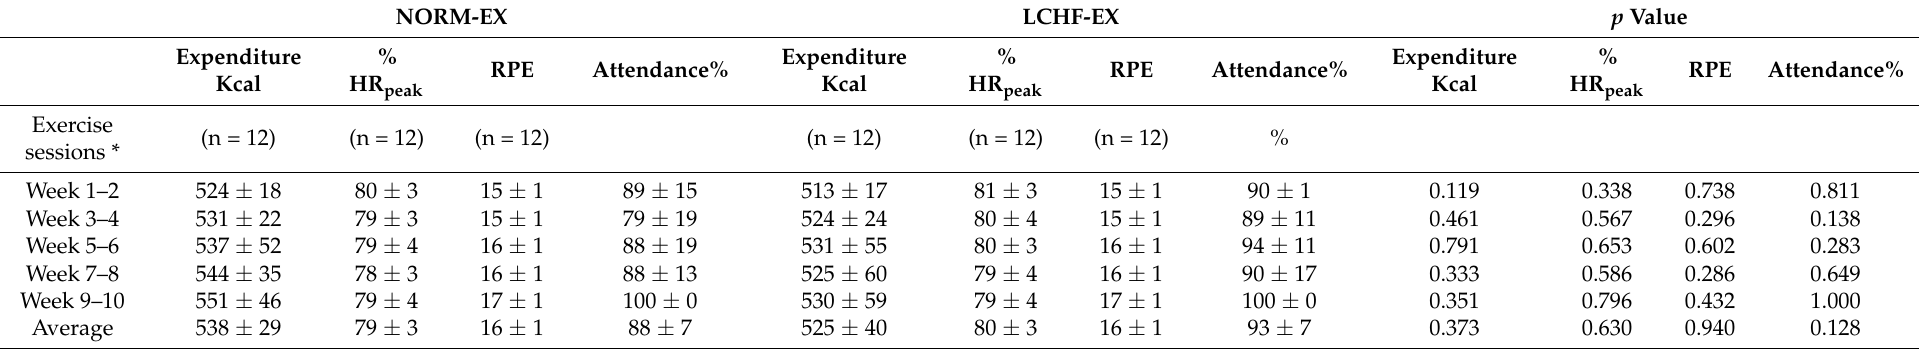
Table 5. Attendance, average energy expenditure, intensity and rate of perceived exertion (RPE) during indoor bicycle exercise.